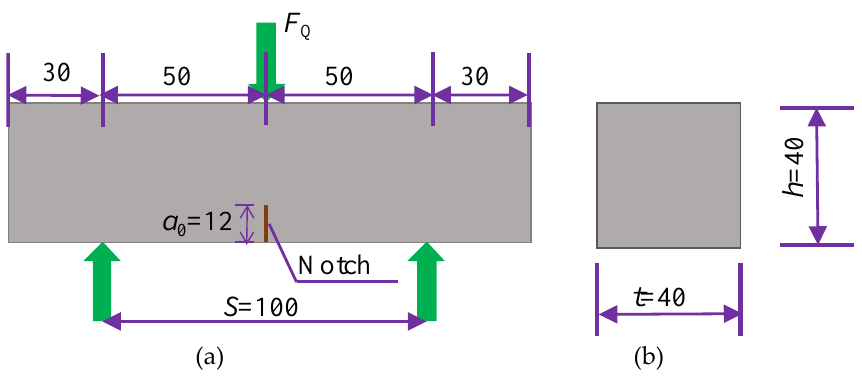
Figure 4. Specimen dimensions and test set up for matrix toughness test (Unit: mm). ( a ) Front elevation; ( b ) Transverse section.